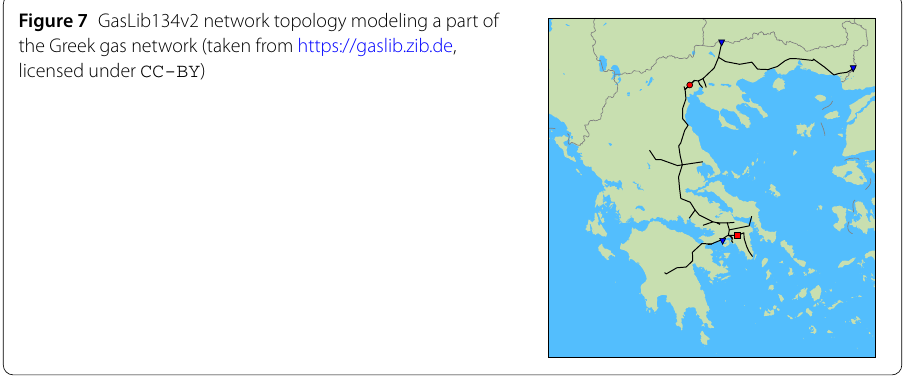
Figure 7 GasLib134v2 network topology modeling a part of the Greek gas network (taken from https://gaslib.zib.de, licensed under CC-BY